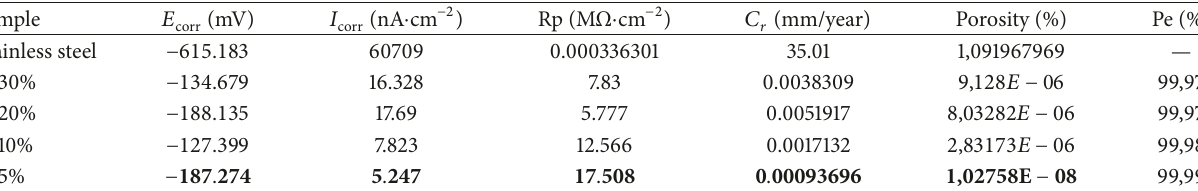
Table 3: Electrochemical parameters obtained from the Tafel method for stainless steel with and without coating of TiO 2 (in the operative conditions of the flow of oxygen) in 3.5% NaCl at 25 ∘ C.